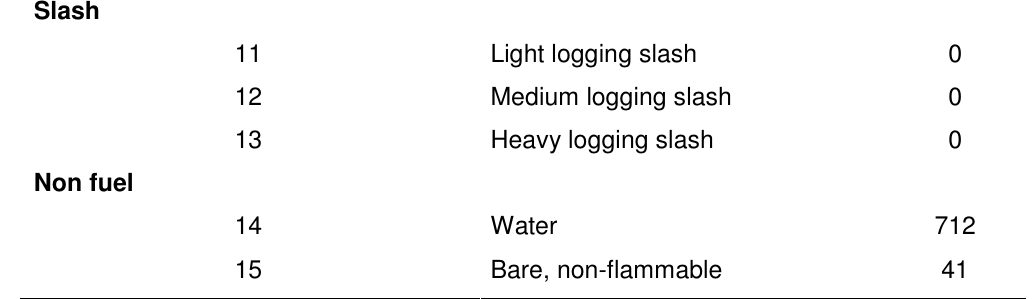
Table 1. Fuel classification system for the MGR study